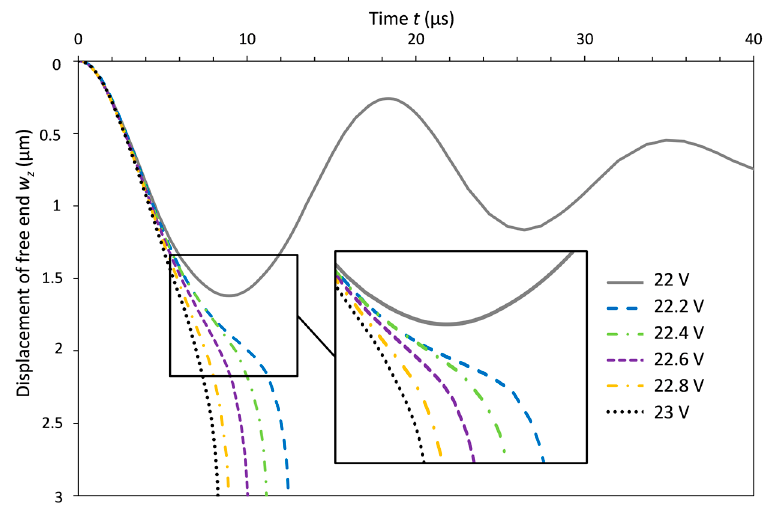
Figure 11. Temporal response of the Al MEMS cantilever tip for different applied voltages; l = 100 μ m, b = 20 μ m and h = 1 μ m.